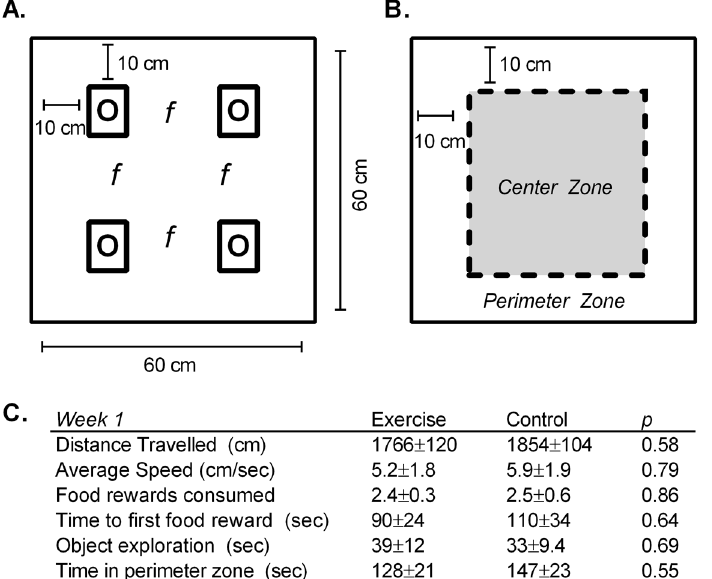
Fig 2. Open Field Assessment. A) Schematic of open field arena indicating placement of four novel objects (O) and four food rewards ( f ). B) Schematic of open field arena indicating 40x40 cm square center zone excluded for assessment of thigmotaxis. C) Data from Week 1, indicating no differences between groups in any of the measures. Data are shown as mean ± SEM; for each group n = 8.